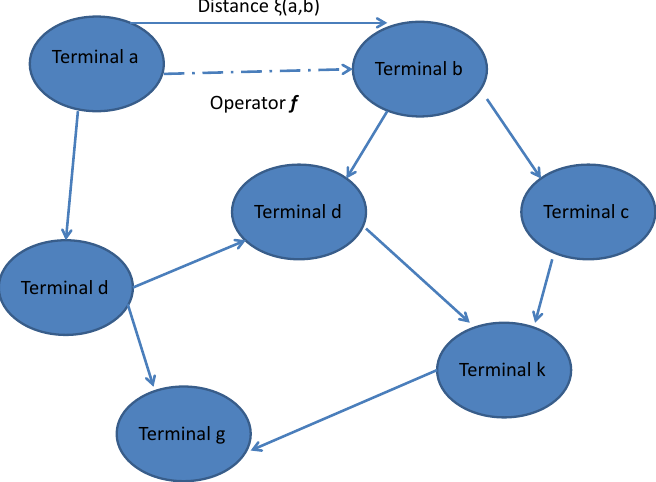
Figure 1. Telecommunications